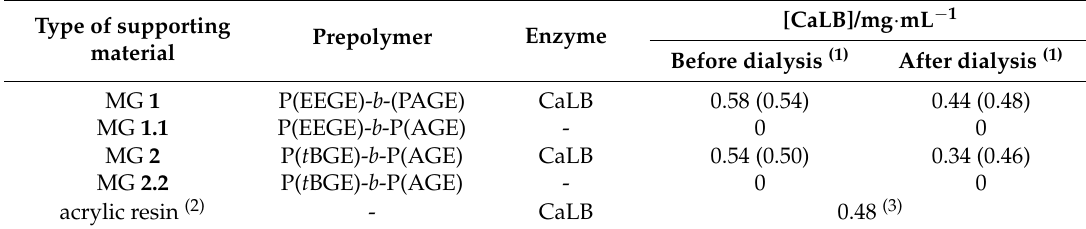
Table 3. Loading efficiency of MG 1 and MG 2 before and after dialysis (MWCO 100 kDa) and